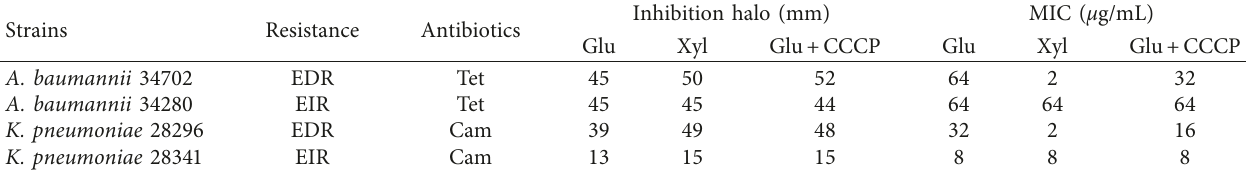
Table 1: Susceptibility profile of A. baumannii and K. pneumoniae strains used in a model of skin infection in mice.